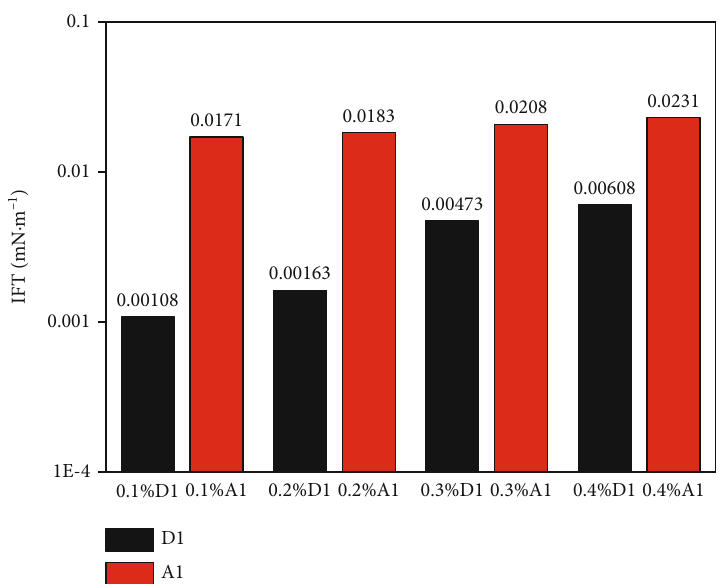
Figure 5: IFT between heavy oil and viscosity reducing surfactant solutions.